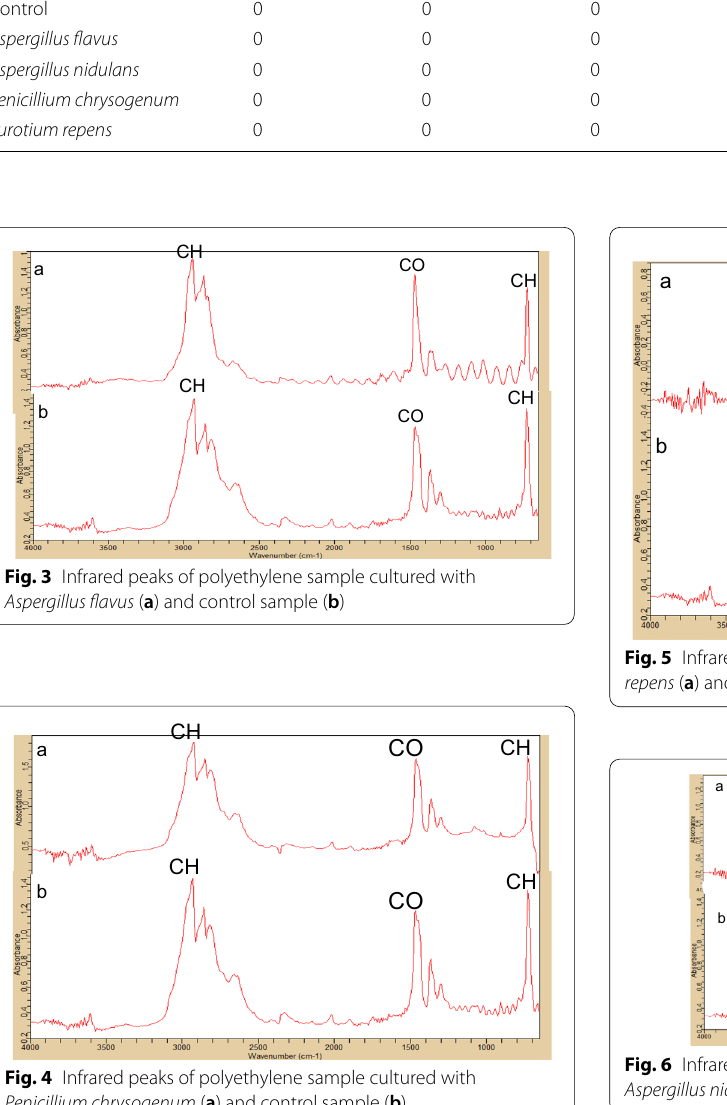
Table 4 Percentage weight loss of the polyethylene strips during six weeks of degradation in static condition Sample